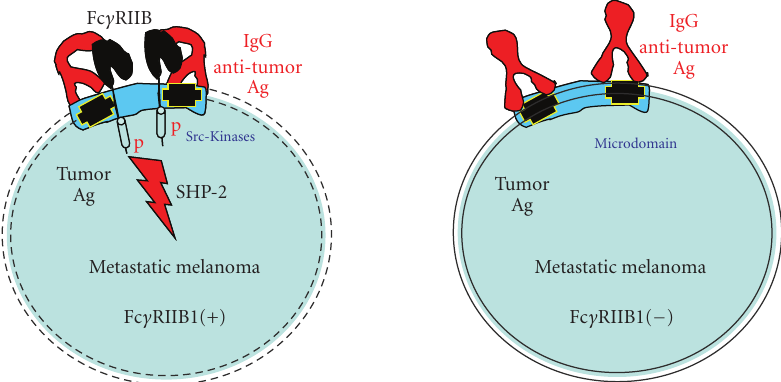
Figure 3: Tumor Fc γ RIIB1 expression inhibits metastatic melanoma growth. Metastatic melanomas that express the Fc γ RIIB1 receptor are sensible to the action of anti-GD2 mAb. In vitro as well as in vivo in immunocompromised mice the tumor Fc γ RIIB1 that are aggregated with the ganglioside GD2 by the mAb are subjected to phosphorylation of the ITIM that recruit the phosphatase SHP-2. SHP-2 dephosphorylates the Protein Tyrosine kinases and initiates an inhibition of tumor